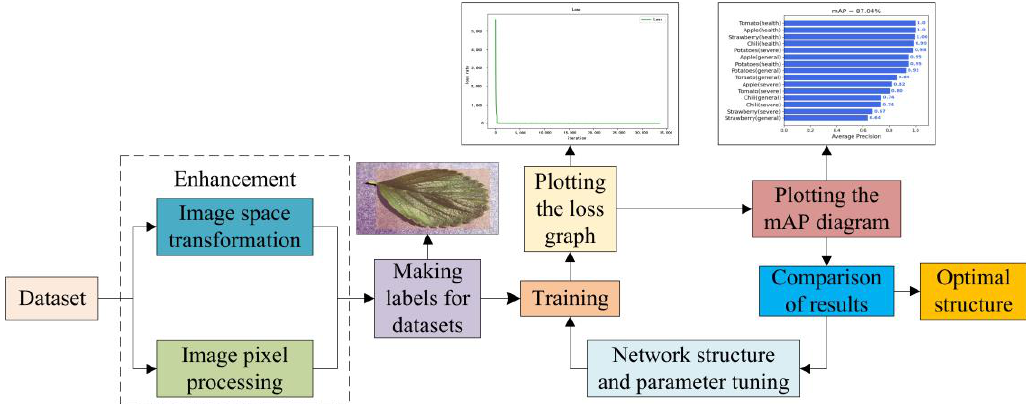
Figure 9. Experimental flow.